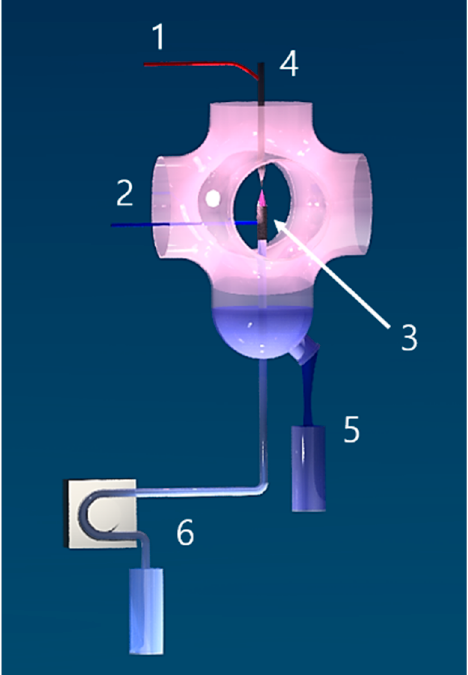
Figure 6. The NTAP-based reaction-discharge system used for PAL production. A layout of the NTAP-based reaction-discharge system applied for continuous production of PAL. (1)—negative potential supplied to a metallic anode. (2)—positive potential supplied to a flowing liquid cathode through a Pt wire. (3)—FLC-dc-APGD being a NTAP source. (4)—a metallic anode. (5)—PAL. (6)—a four channel peristaltic pump used for pumping the NH 4 NO 3 solution.